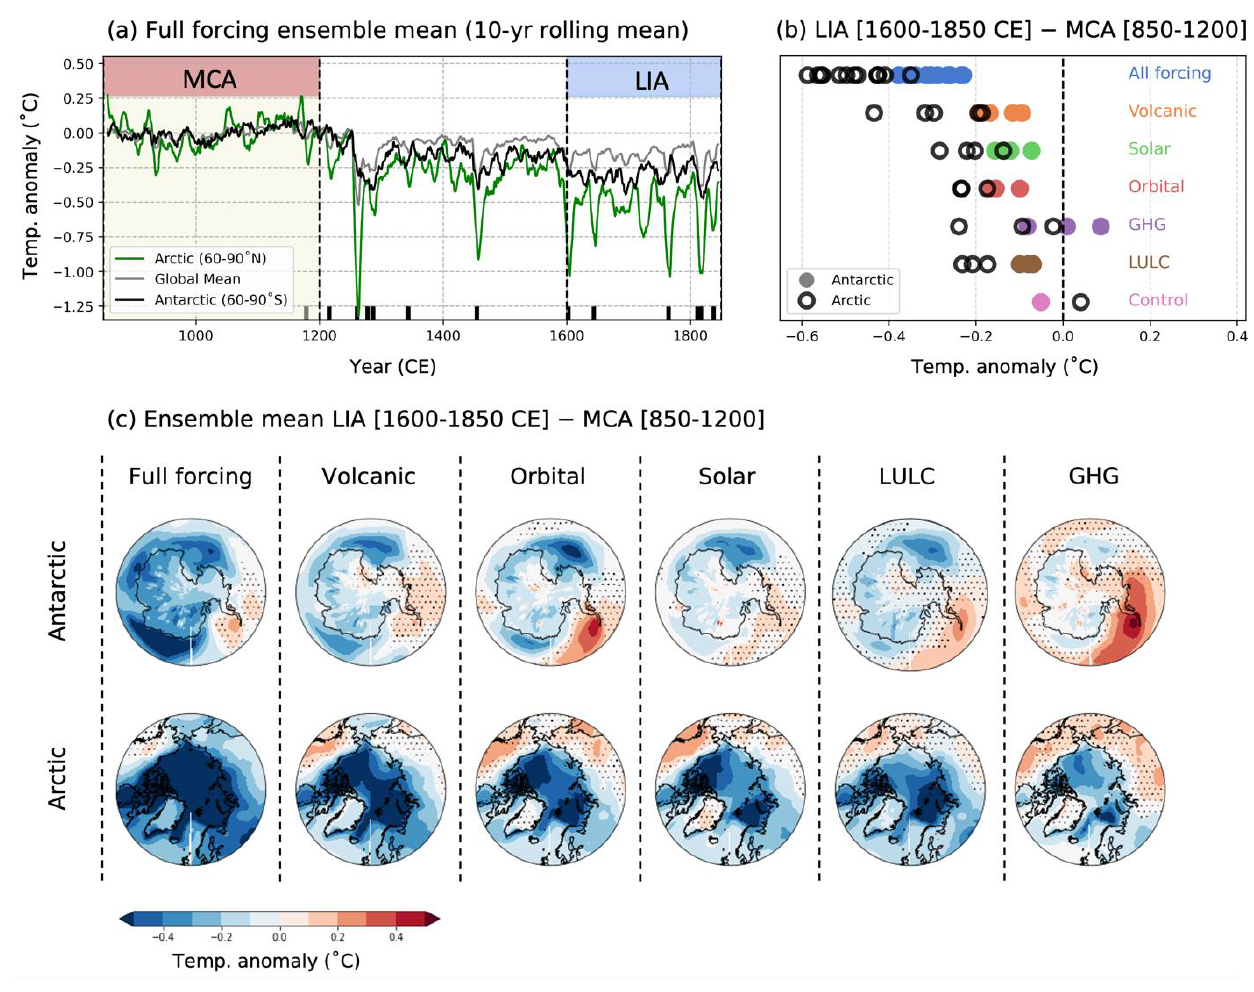
Figure 4. Comparison between Antarctic and Arctic temperature evolution during the LME; ( a ) average Antarctic, Arctic, and global temperature evolution highlighting the timing of the core periods of the MCA (850 – 1200 CE) and LIA (1600 – 1850 CEE). Anomalies were computed relative to the base period of 850 – 1200, and a 10-year rolling mean was applied. Black bars indicate the timing of the 10 largest LM volcanic eruptions; ( b ) LIA-MCA temperature anomaly in the Arctic (north of 60° N) and Antarctic (south of 60° S) in full and single forcing simulations; ( c ) ensemble mean LIA-MCA temper- ature difference in full and single forcing simulations. Stippling indicates differences that were not statistically significant at the 95% level using a Students t- test.